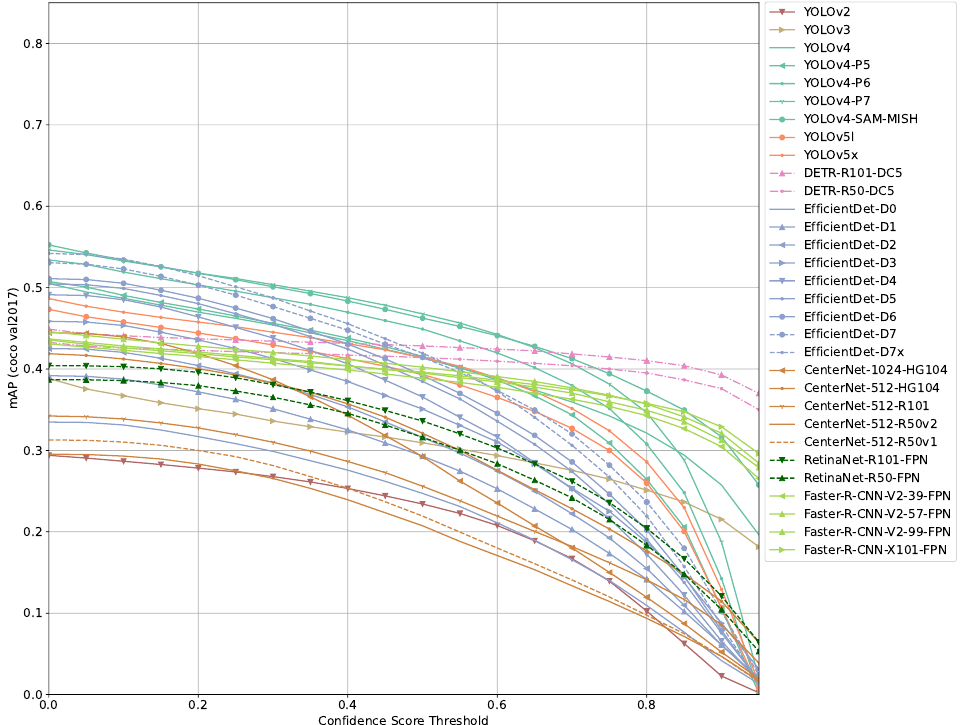
Figure 2. COCO mAP results of models selected (bigger